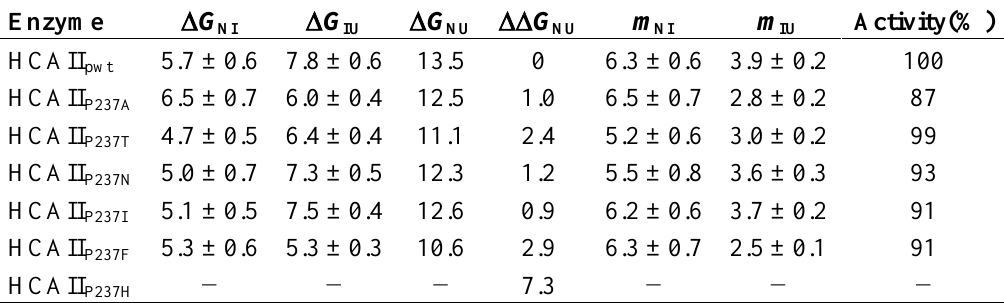
and the mutants. pwt from that of the mutants. pwt as pwt